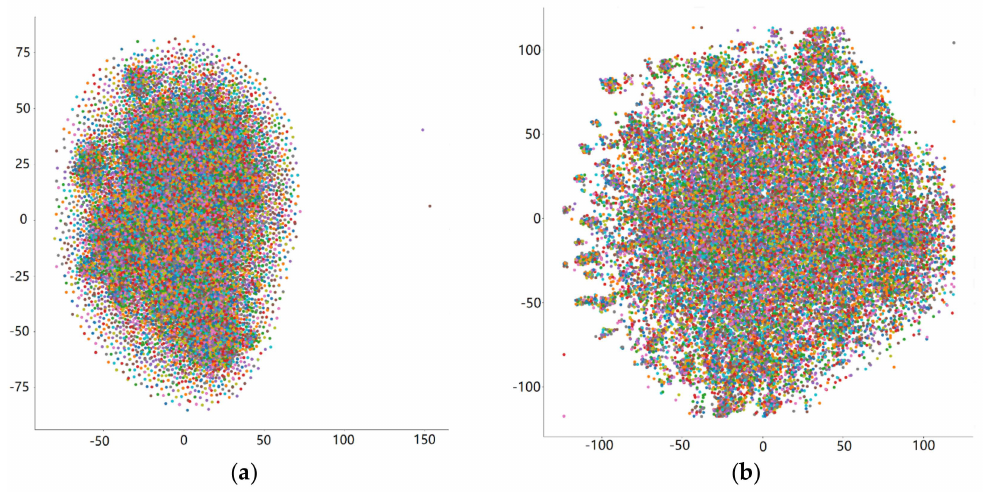
Figure 3. The results of DRA on the learned vectors. ( a ) DRA result where l = 2; ( b ) DRA result where l =